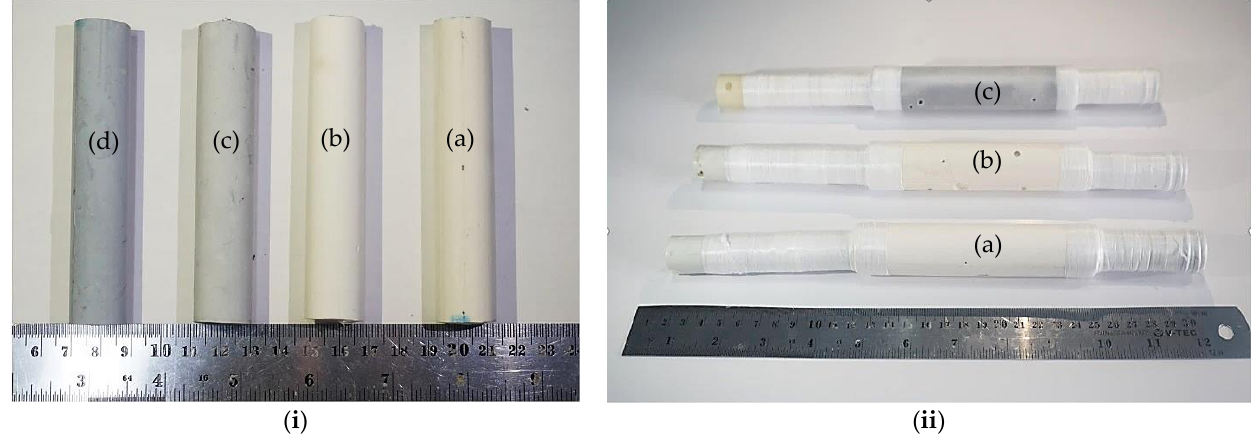
Figure 1. ( i ) Unsupported, and ( ii ) supported pervaporation membranes for desalination of seawater: (a) geopolymer; (b) Geo–TiO 2 (3); (c) Geo–rGO–TiO 2 (0.5, 3); (d) Geo–rGO–TiO 2 (1, 3). All specimens were stored in the open air for 28 days prior to any characterization.